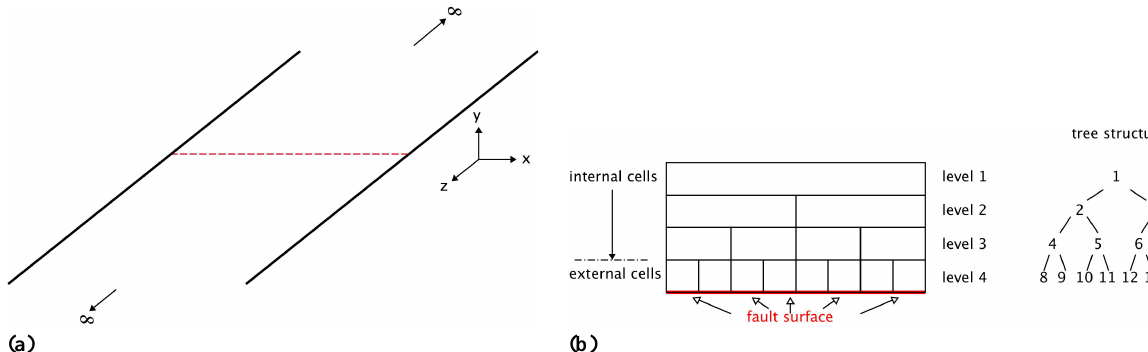
Fig. 1. Fault geometry, cell and tree structure of the plane strain Barnes-Hut implementation. (a) Schematic representation of a fault in a whole space in plane strain. This is the geometry that is used in all the calculations in this paper. The fault is in the plane containing the z and x axes; the y direction is the fault normal. It has a finite length in the x direction and extends infinitely in the positive and negative z directions. The red dashed line, shown for reference, is the intersection of the fault with the plane containing the y and x axes at z=0. (b) Cell and tree representation of the fault. Left panel shows the fault trace from (a) in red, that is, the intersection of the fault with the plane containing the y and x axes, corresponding to the red dashed line in (a) . The fault is divided into 2 3 equi-dimensioned external cells. Above the fault in the left panel are the 2 3 − 1 internal cells, labeled by level. Right panel shows the internal and external cells schematically as a tree structure, a choice of corresponding cell numbers, and lines connecting parent to daughter